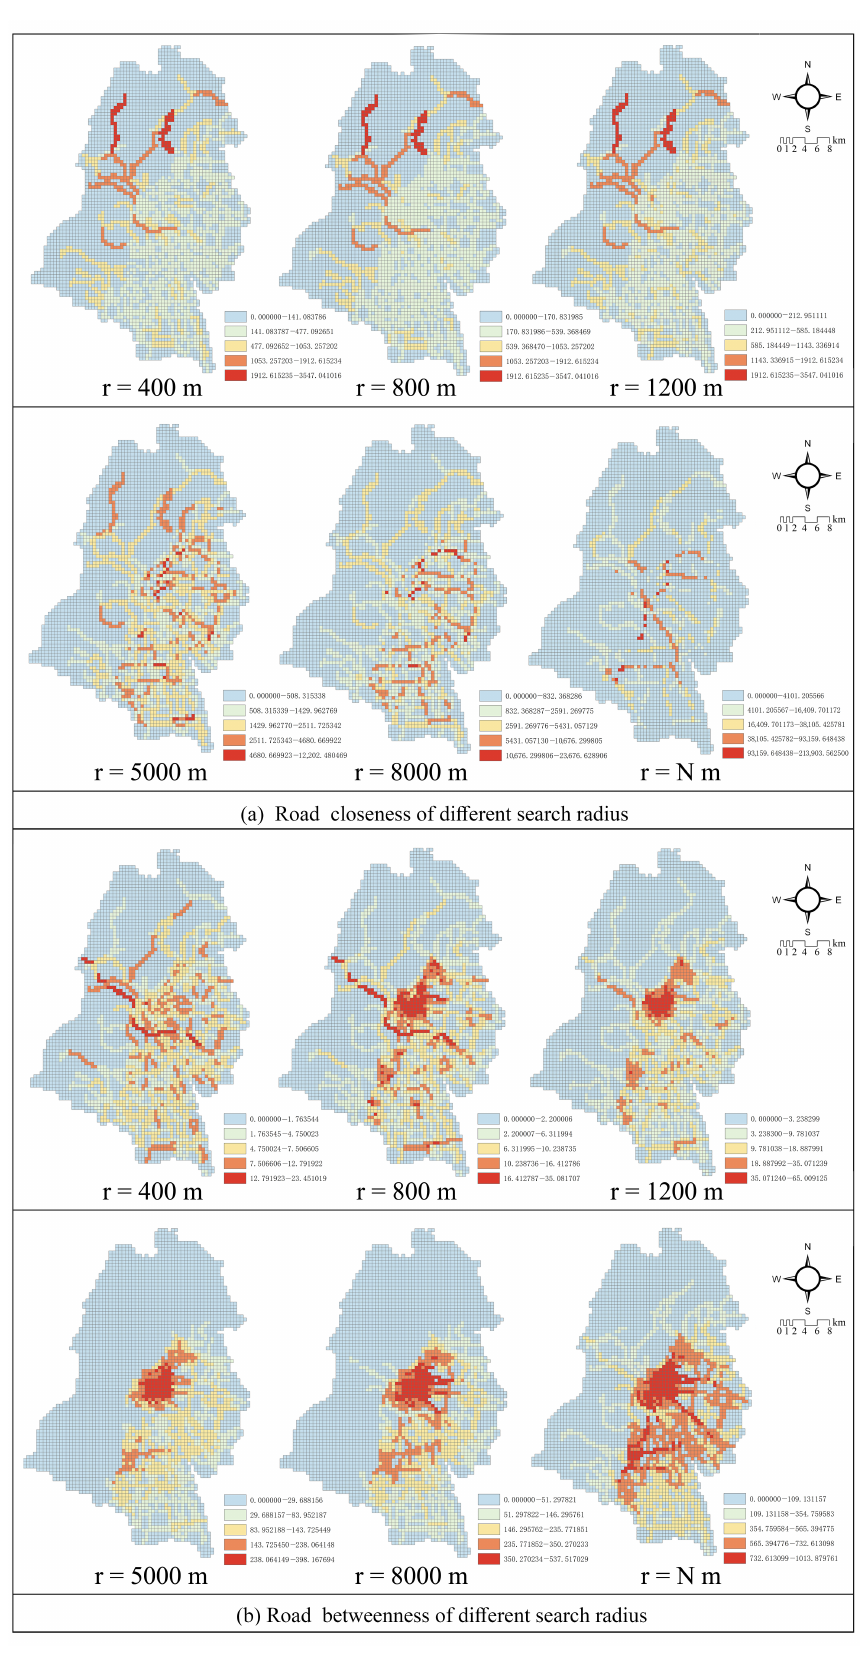
Figure 3. Road closeness ( a ) and betweenness ( b ) of different search radius. The search radius equal to 400 m, 800 m, 1200 m, 5000 m, 8000 m, and N